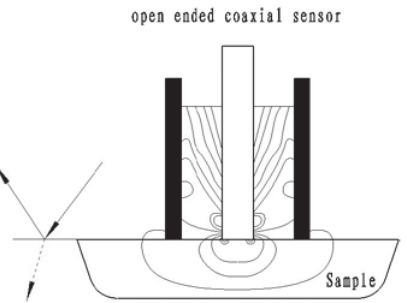
Fig. 2: The schematic diagram of the open-ended coaxial sensor